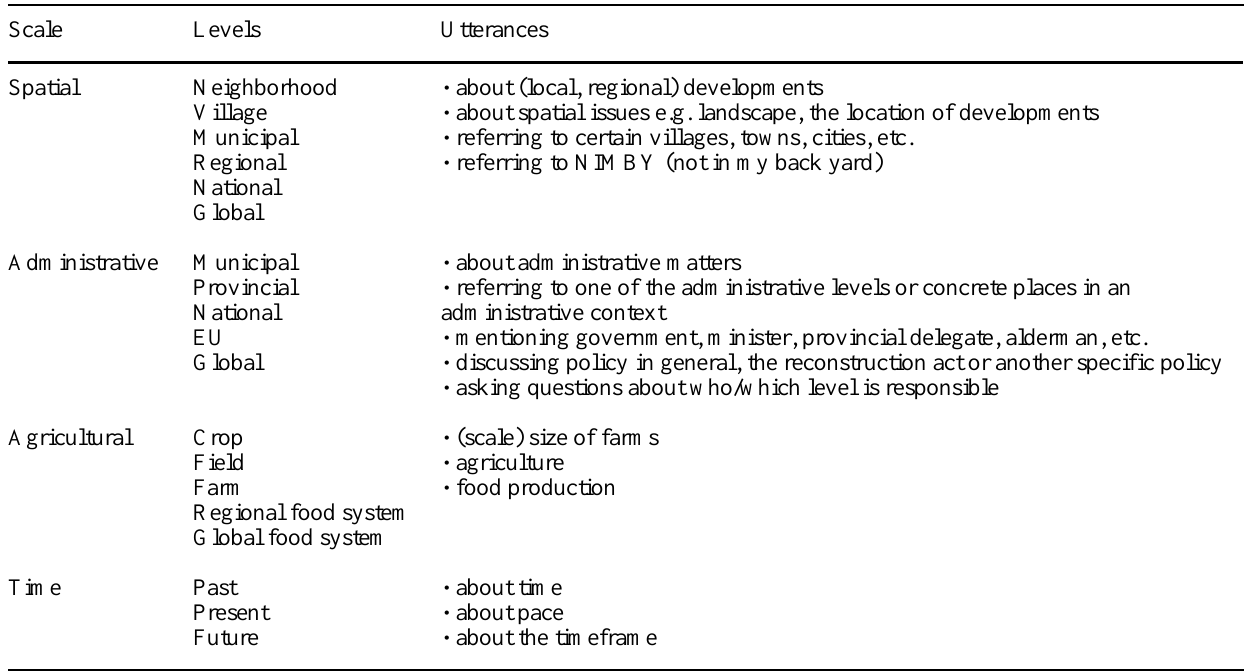
Table 1. A theoretical division of